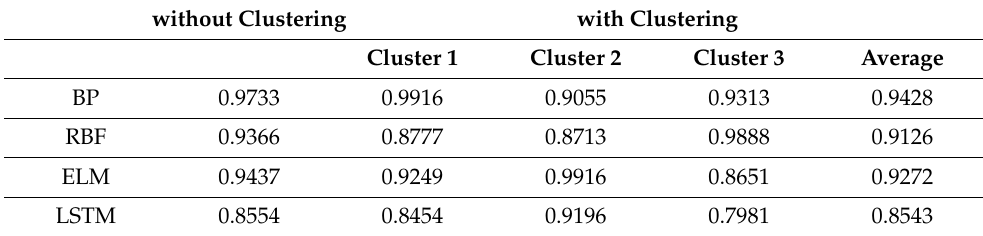
Table 11. R 2 of solar radiation in autumn.